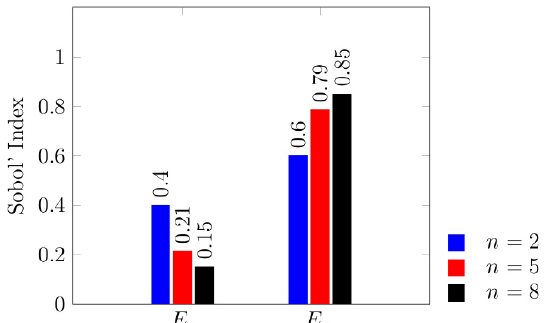
Figure 4. Sensitivity study using the first order Sobol’ Indices for n = 5 where the Young’s modulus of the both the ceramic and plate are the input random variables.